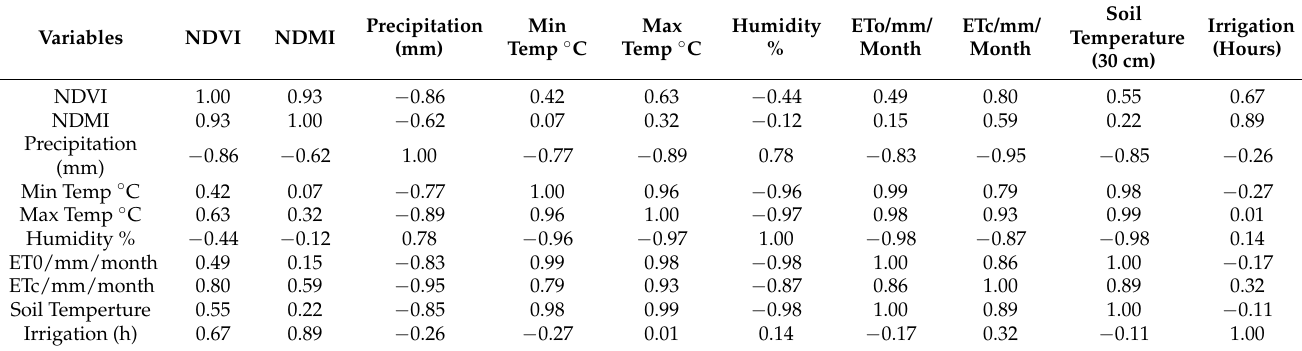
Table A1. Correlation matrix (Pearson